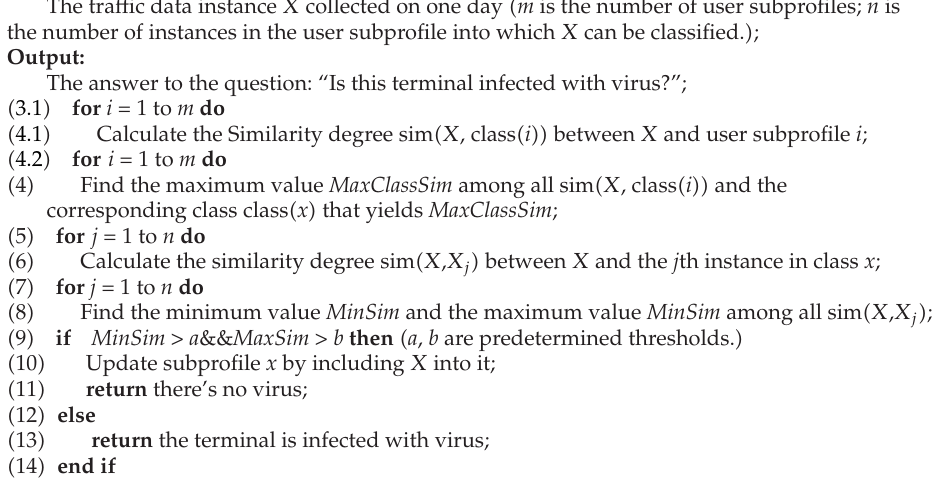
Algorithm 1: Virus detection